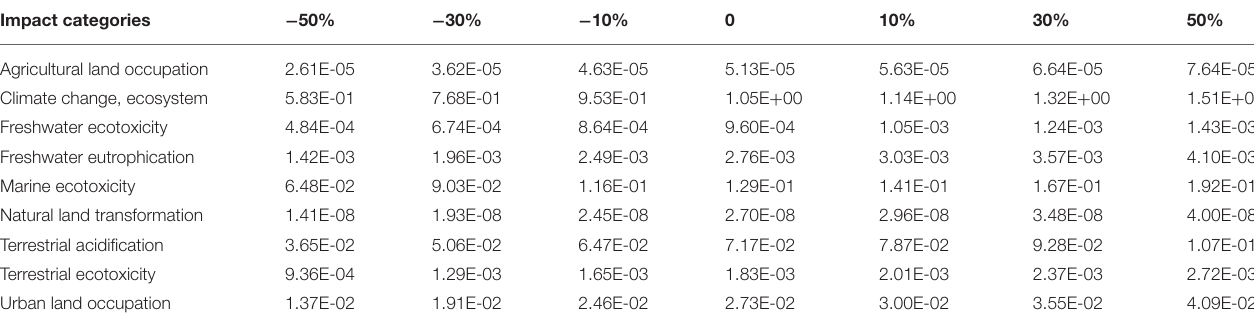
TABLE 5 | Sensitivity analysis results for quantitative variations across each endpoint impact category for construction phase (in species.yr).